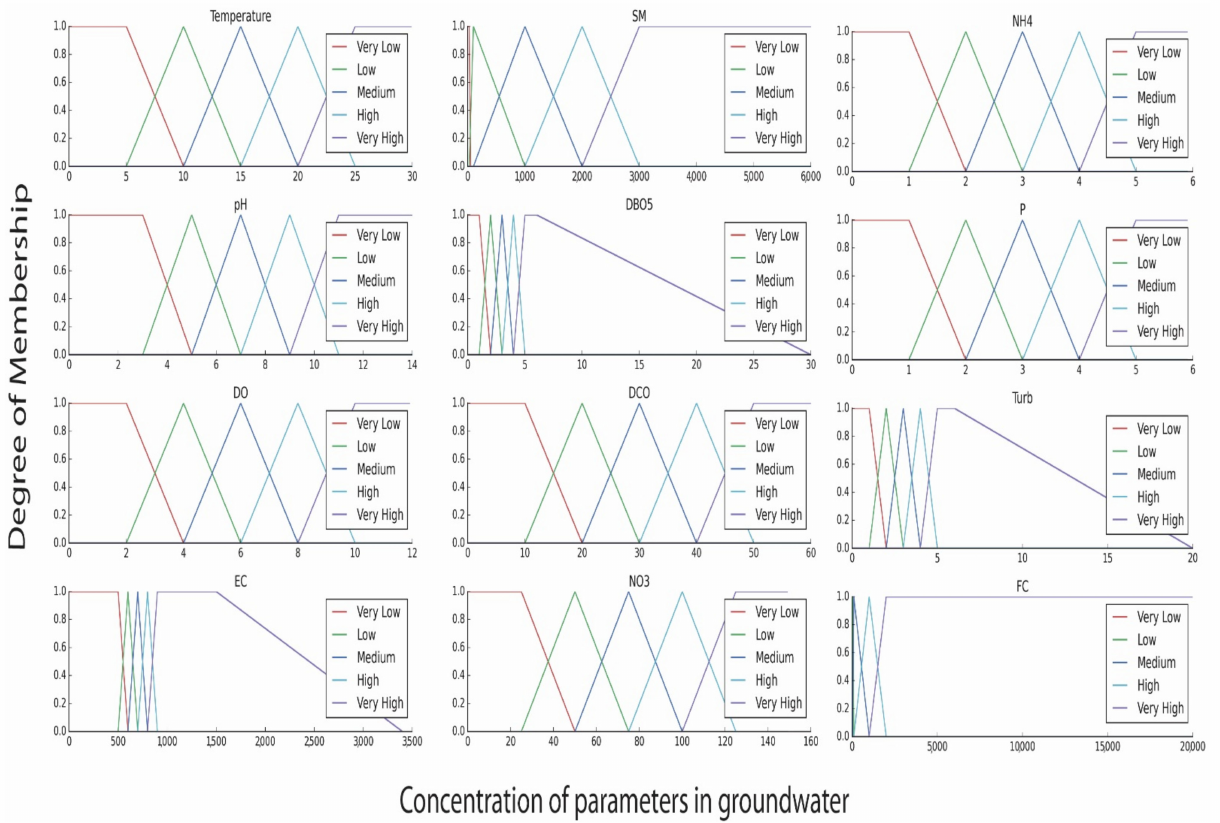
Figure 6. Membership functions of different input parameters (T ◦ , pH, DO, EC, SM, DBO5, DCO, NO3-, NH4+, PO43-, TURB, and FC).